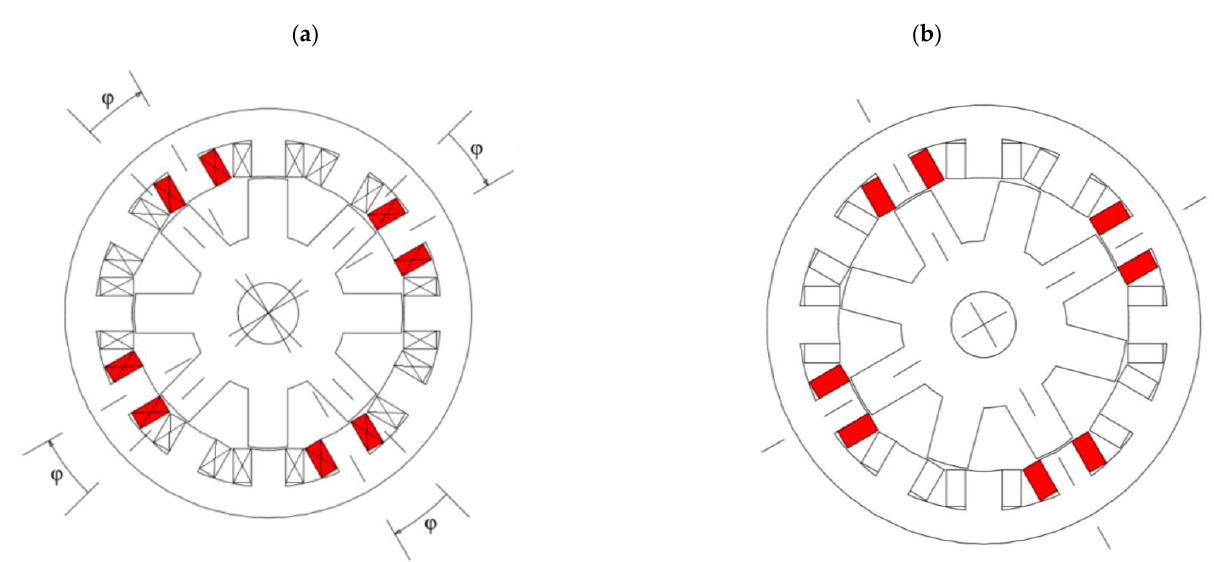
Figure 4. Movement of the rotor during 12/8 SRM motor operation: ( a ) While energizing the phase band, the rotor will move by the angle ϕ aiming at the coaxial position; ( b ) rotor position after moving by the angle ϕ .